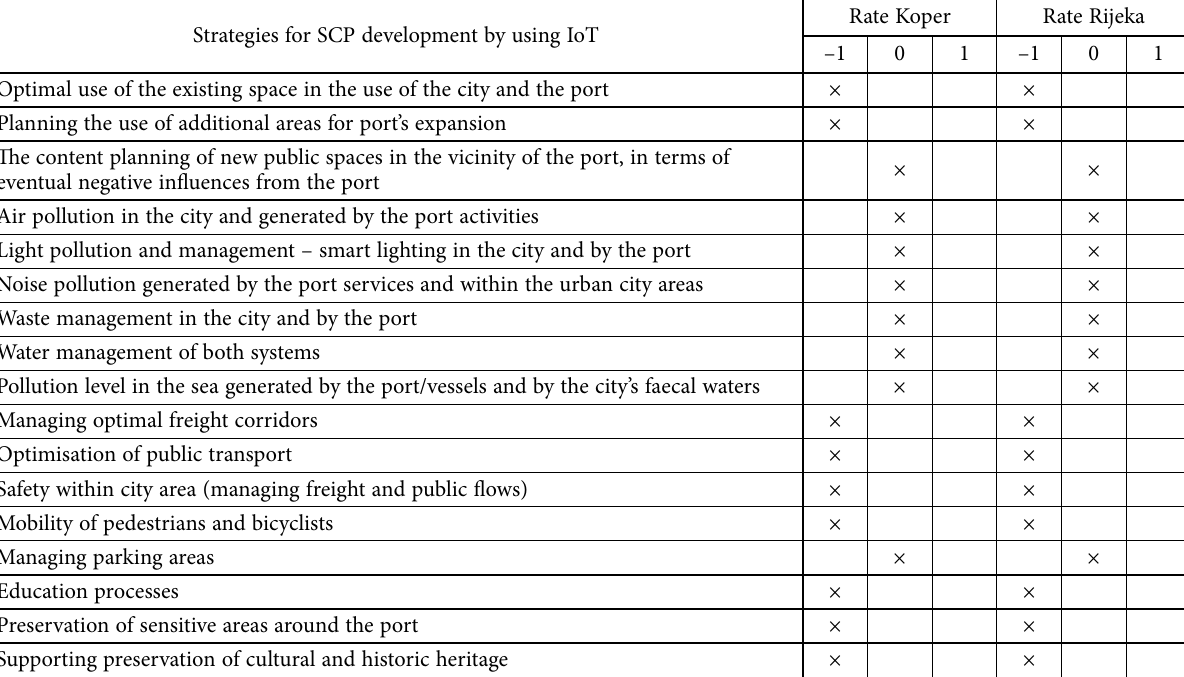
Table 4. Analysis of proposed strategies for SCP supported by IoT in Koper and Rijeka (source: prepared by authors) Strategies for SCP development by using